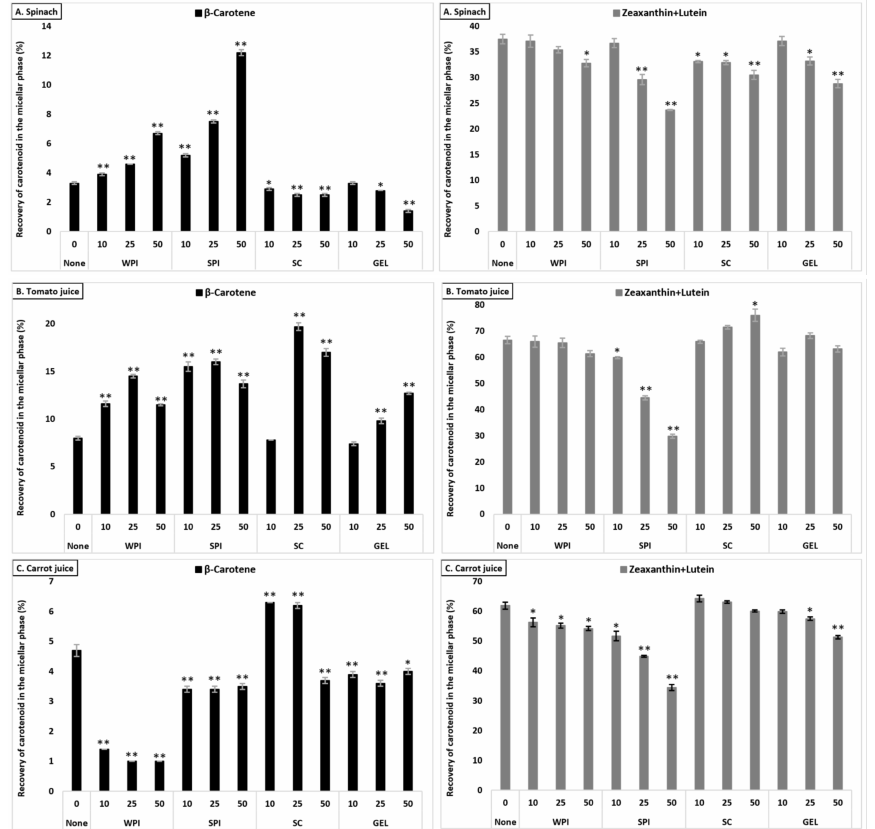
Figure 2. Average bioaccessibility (%) of carotenoids following simulated GI digestions of spinach ( A ), tomato juice ( B ), and carrot juice ( C ). Each bar represents the bioaccessibility of either β -carotene or lutein+zeaxanthin recovered from the aqueous micellar fraction at the end of the in vitro GI digestion. Bioaccessibility is expressed as explained in Figure 1 heading. Bars represent means ± SD of n ≥ 4 and N ≥ 2 (sets repeated at different days). Columns labelled with either * ( p < 0.05) or ** ( p < 0.001) were significantly different from the control condition (no added